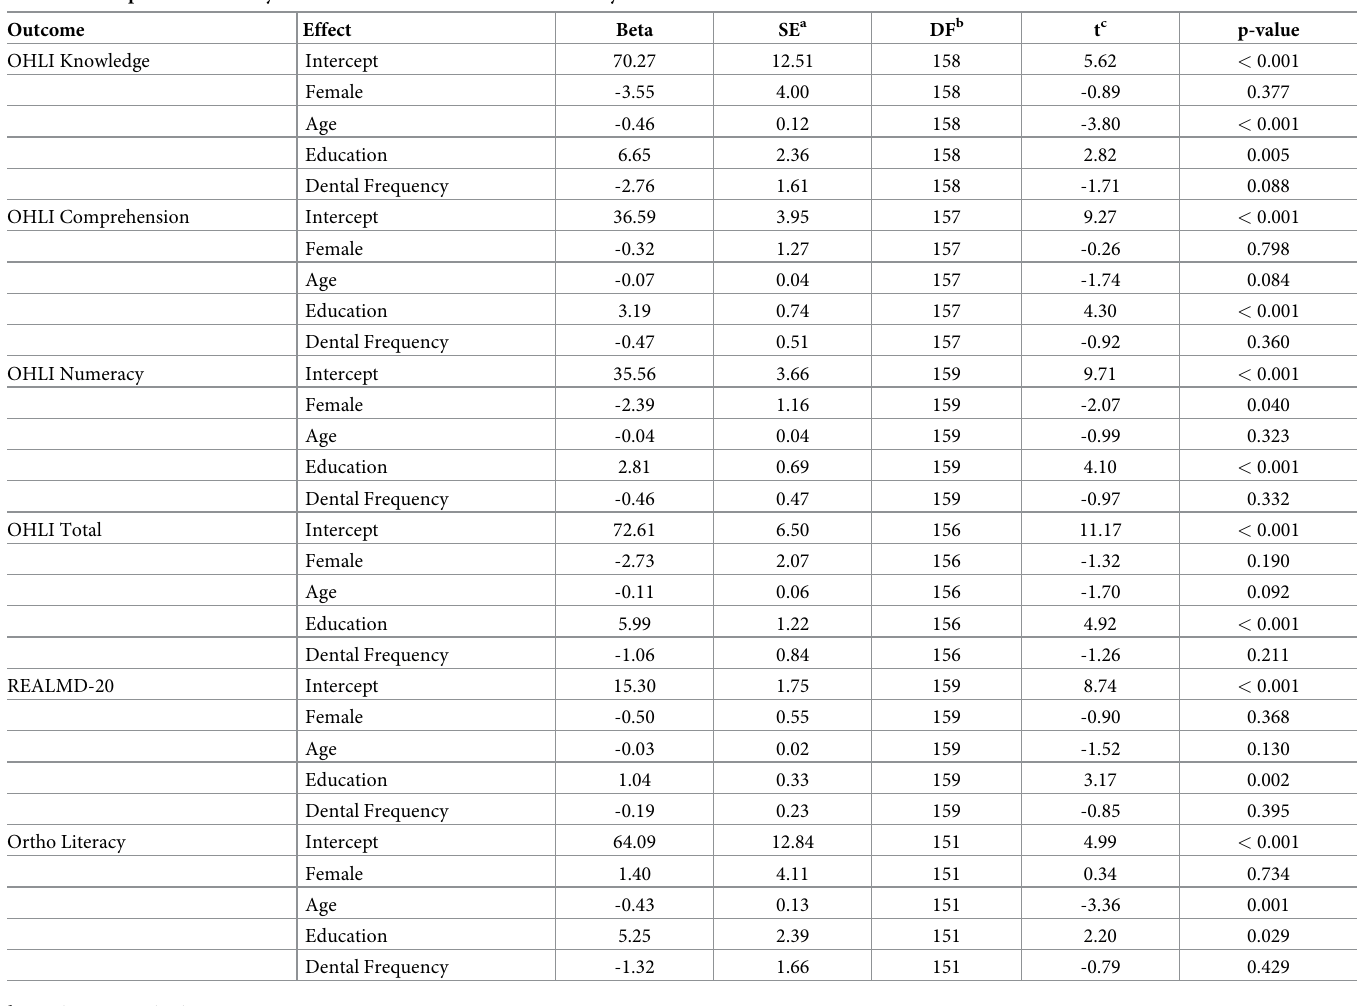
a SE indicates standard error. b DF indicates degrees of freedom. c t indicates t